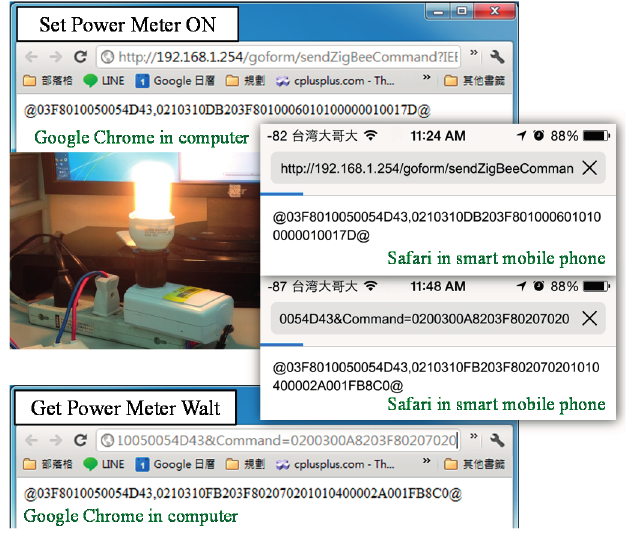
Figure 11. Using HTTP to send and return